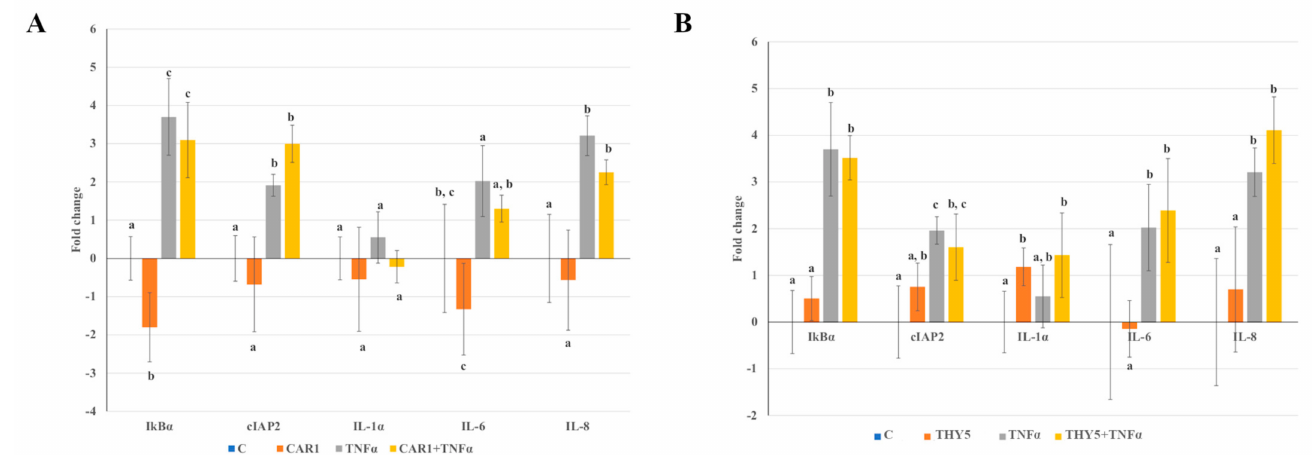
Figure 6. Study of NF-kB pathway gene expression in Caco-2 cells treated with ( A ) CAR1 and/or TNF- α and ( B ) THY5 and/or TNF- α . Caco-2 cells were pre-treated for 1 h with 0.02% CAR1 or THY5 and then treated for 1 h with 15 ng/mL TNF- α . IkB α , cIAP2, IL-1 β , IL-6 and IL-8 gene expression was analyzed by real-time PCR. Data are expressed as the fold change (log2) ± SD of two independent experiments, carried out in triplicate. Means without a common letter significantly differ, p <